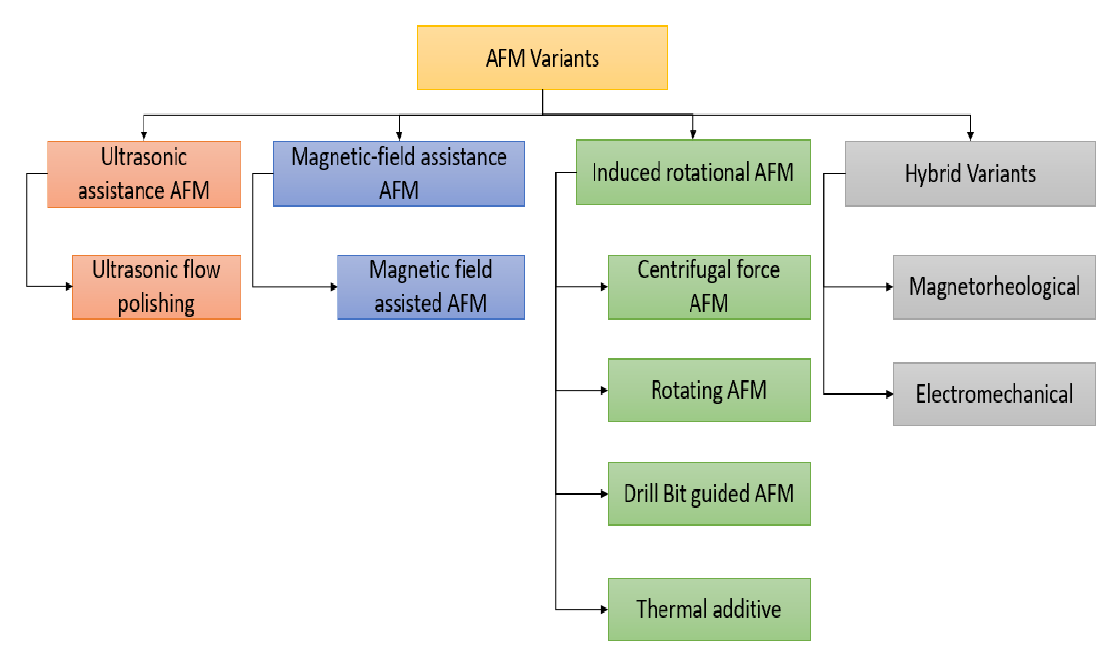
Figure 8. Classification of AFM variants.